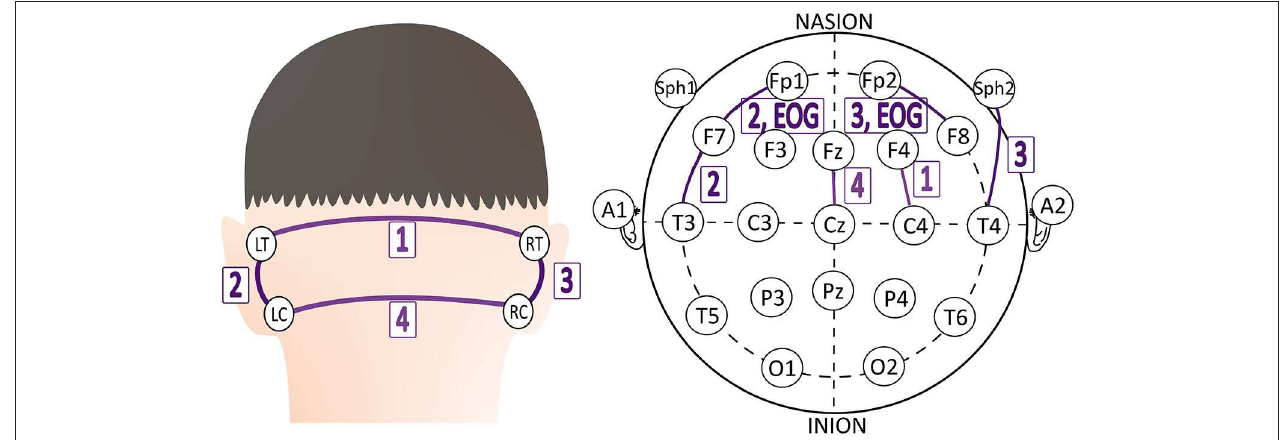
FIGURE 3 | The best match-up scalp EEG channel of each behind-the-ear EEG channel on 12 patients (24).